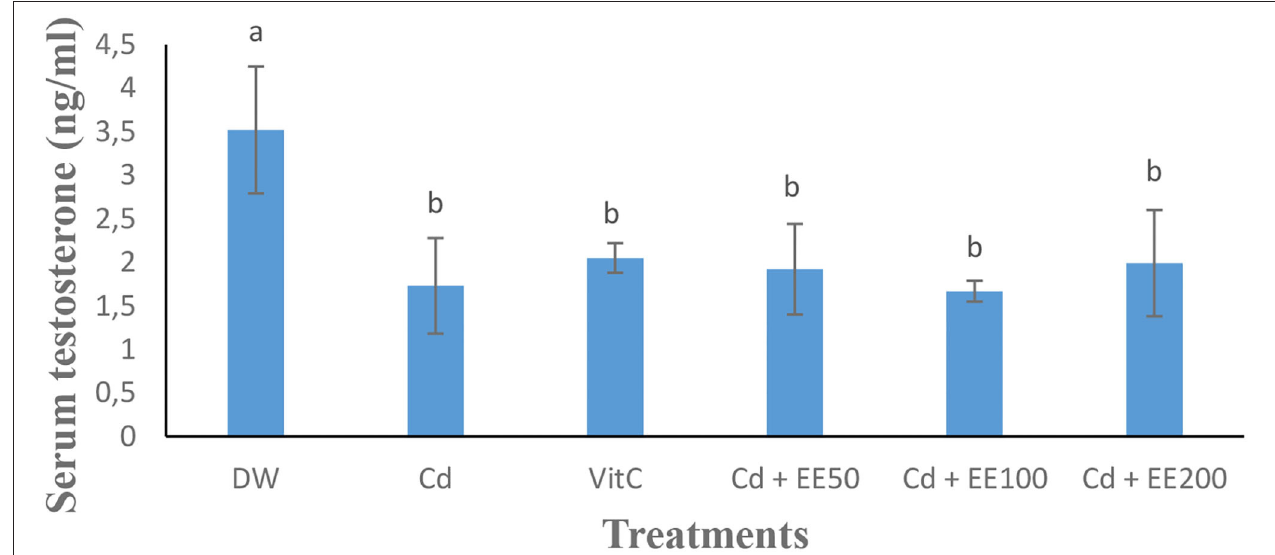
FIGURE 1 | Effects of different concentrations of ethanolic extract of Polygonum limbatum meism (EEPLM) on serum testosterone level in male guinea pigs exposed to cadmium chloride. a, b: histogram values with the same letters are not significantly ( p > 0.05) different.